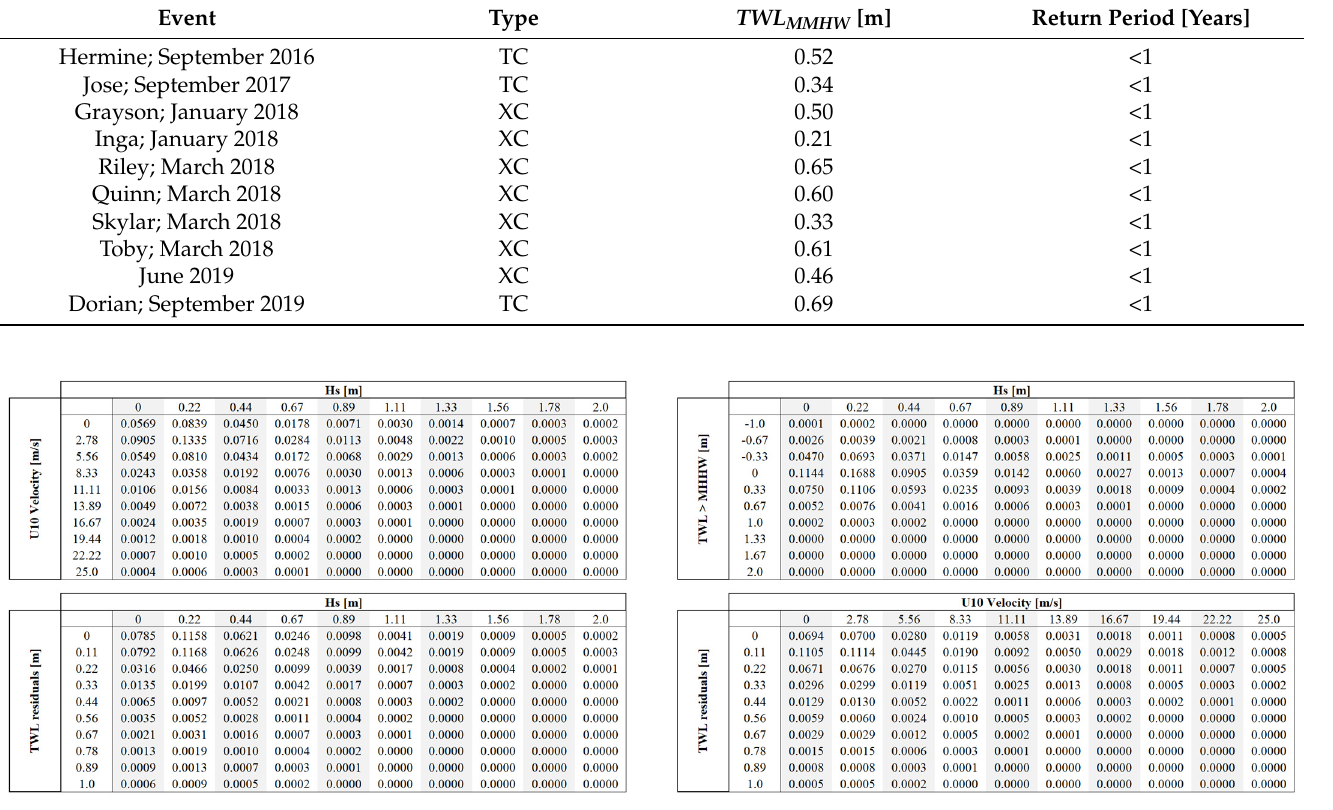
Figure A1. Tables containing the JP values for the plots in the red boxes from Figure 8. Table A3. Values for Figure 9. The final column (All) shaded in orange consists of the Storm, Sunny, Wind, and TWL res events. The grey columns were not included in “All” column.